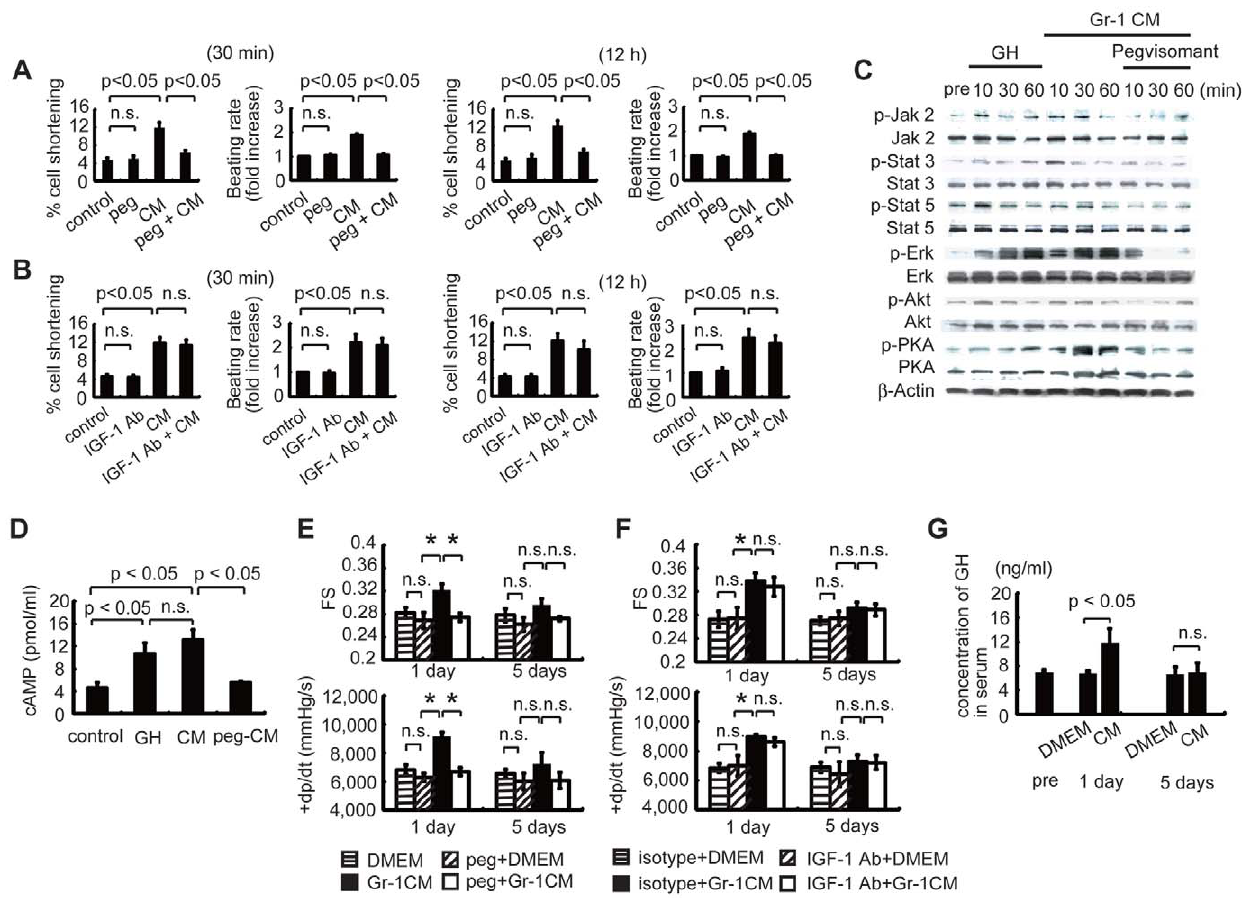
Figure 5. GH mediates the cardioprotective effects of Gr-1( + ) cell-derived CM. (A) Pegvisomant (PEG) treatment inhibited the Gr-1( + ) cell CM-mediated improvements cardiomyocyte cell shortening and beating rate at 30 min and at 12 h after treatment ( n =27 cells per group). Left graphs, cell shortening; right graphs, beating rate. (B) Anti-IGF-1 antibody failed to affect the Gr-1( + ) cell CM-mediated improvements in cell shortening or beating rate at 30 min or at 12 h after treatment ( n =23 cells per group). Left graphs, cell shortening; right graphs, beating rate. (C) GH and CM from Gr-1( + ) cells phosphorylated Akt, Erk, Jak2, Stat3/5 and PKA in cardiomyocytes ( n =3), which was inhibited by pegvisomant ( n =3). (D) GH (500 pg/ml) and CM from Gr-1( + ) cells increased the cAMP concentration in cardiomyocytes ( n =5), which was inhibited by pegvisomant ( n =5). (E, F) Cardiac function analysis by echocardiography (upper graphs, n =8) and catheterization (lower graphs, n =8). Pegvisomant (E), but not anti-IGF- 1 antibody (F), inhibited the improvements in FS and + dp/dt elicited by the infusion of CM from Gr-1( + ) cells. * p , 0.05 ( n =8). (G) Serum GH concentrations in DOX mice treated with CM from Gr-1( + ) cells ( n =4 per group). The infusion of CM from Gr-1( + ) cells from wild-type mice increased the serum GH concentration at 1 d, but not at 5 d. Data are means 6